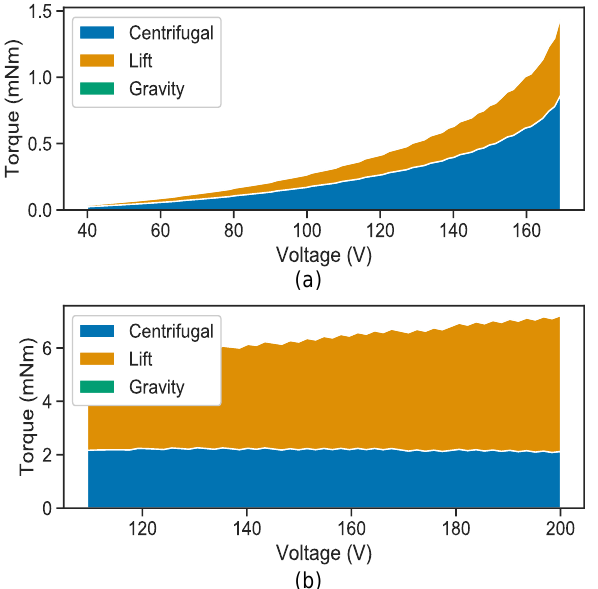
Figure 8. Contributions of different forces on the unfolding torque in the ( a ) folded state and ( b ) unfolded state at 𝜔 = 95 Hz.